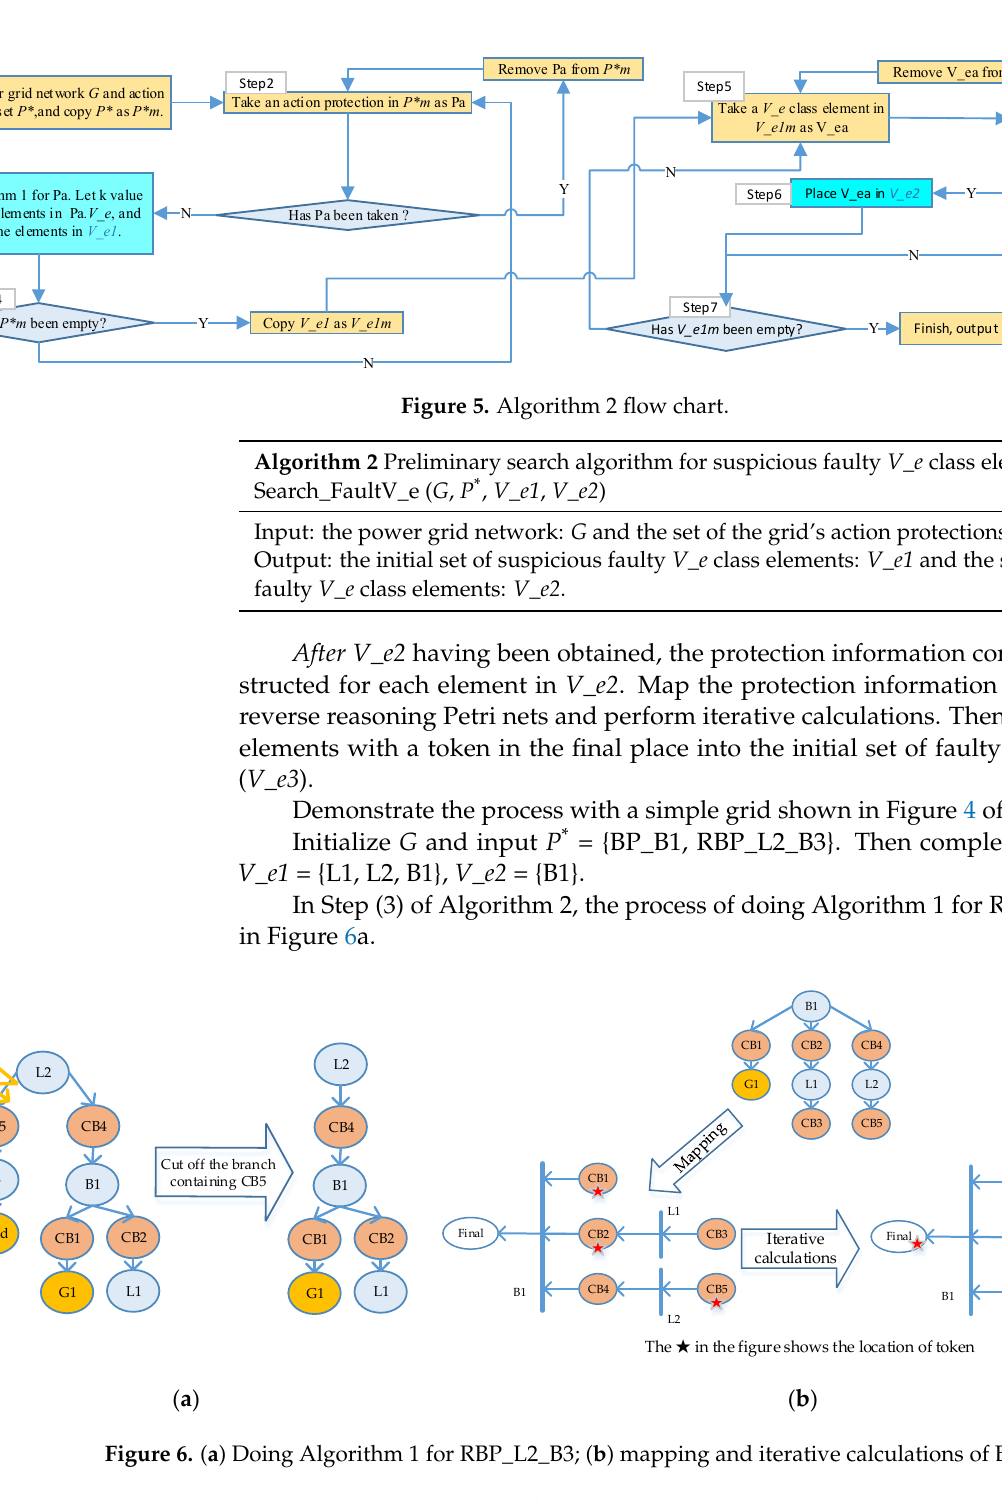
Algorithm 2 Preliminary search algorithm for suspicious faulty V_e class elements: